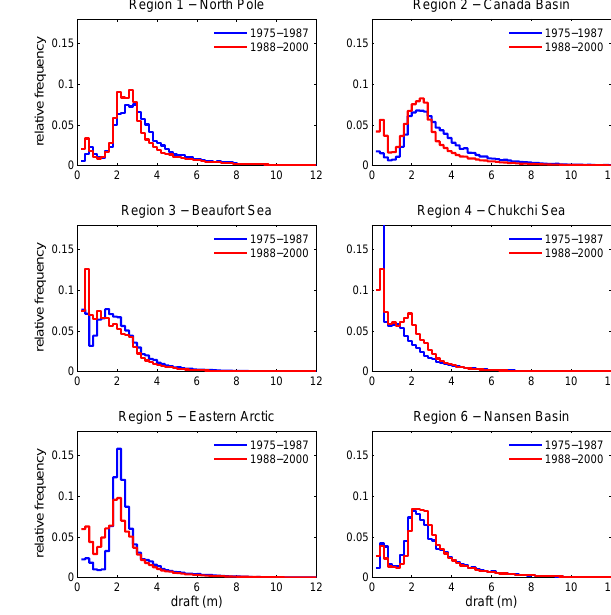
Fig. 4. Regional Autumn draft distributions during periods 1975– 1987 (blue line) and 1988–2000 (red line). Bin width